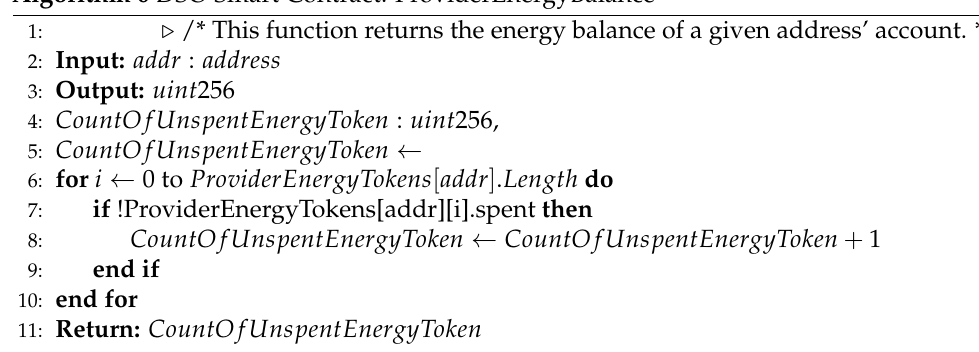
Algorithm 6 DSO Smart Contract: ProviderEnergyBalance